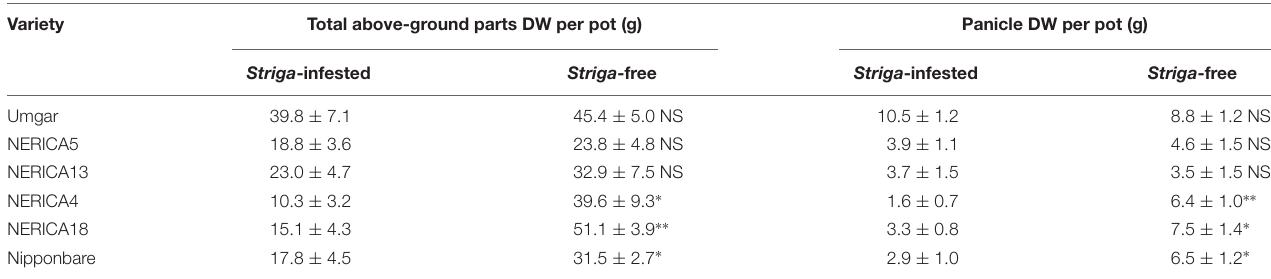
TABLE 1 | Effects of Striga hermonthica on rice total above-ground parts and panicle DW in the second open-air pot experiment in 2012.